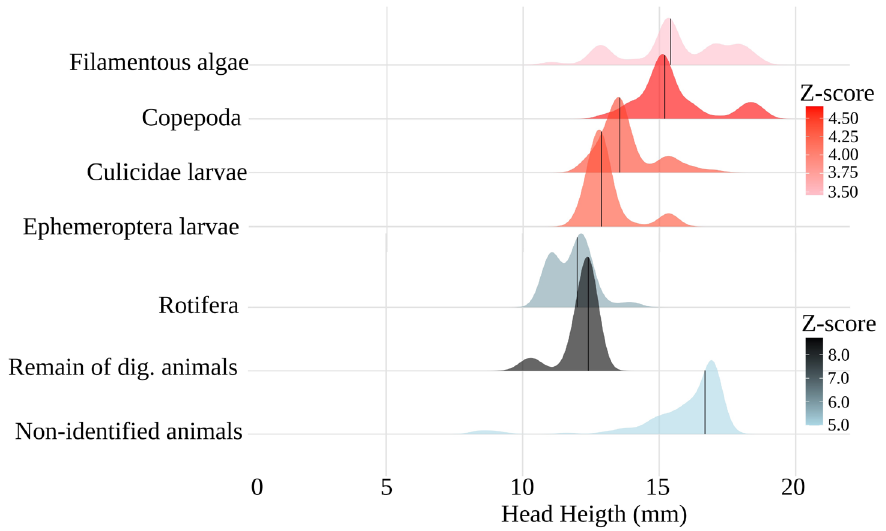
Figure 5. Variation of Eigenmannia desantanai food items along ontogeny based on Threshold Indicator Taxa Analysis. The higher the value of the Z-score, the better the indication of the